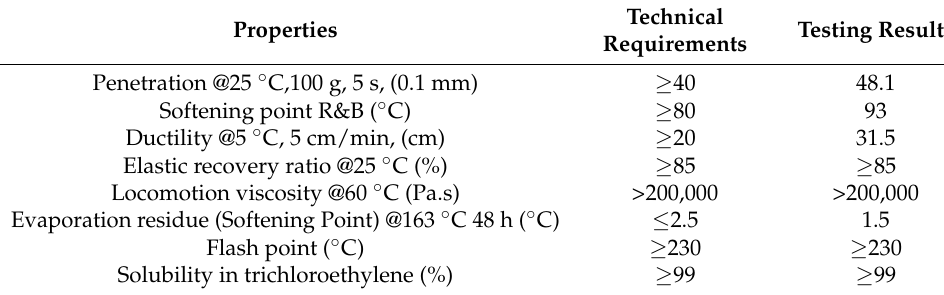
Table 3. Properties of the S-HV-modified